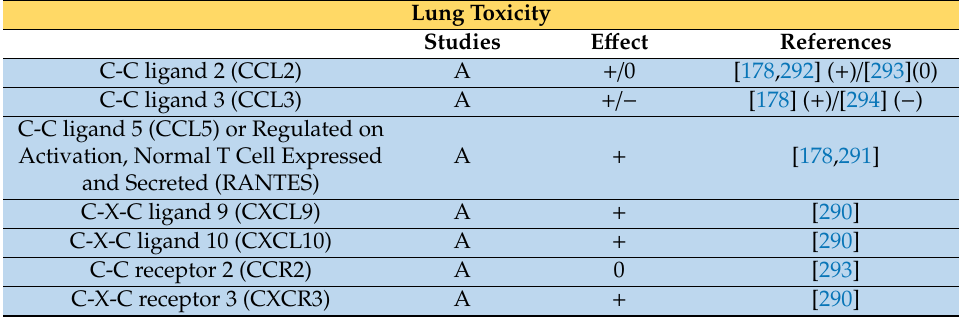
Table 5. Lung toxicity occurrence / severity in animals (A) or humans (H). See the Methods section regarding the reporting of results (Section 3.2).